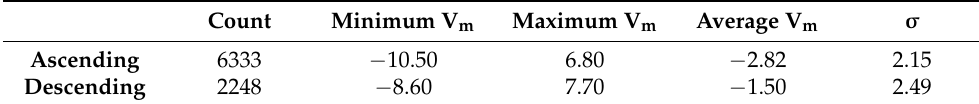
Table 5. Statistics of the mean velocity V m (mm/y) of the active PSs of the selected area of Zona Franca .